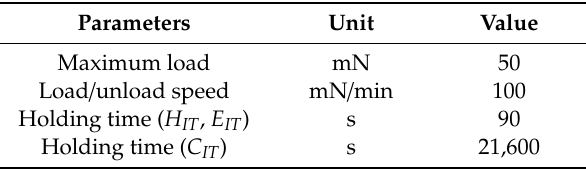
Table 3. Process